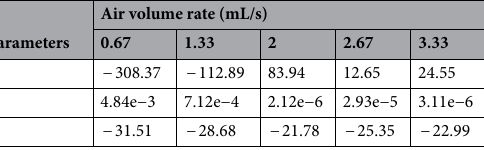
Table 1. Curve parameters of CO concentration varying with temperature under an air volume rate range of 0.67–3.33 mL/s.